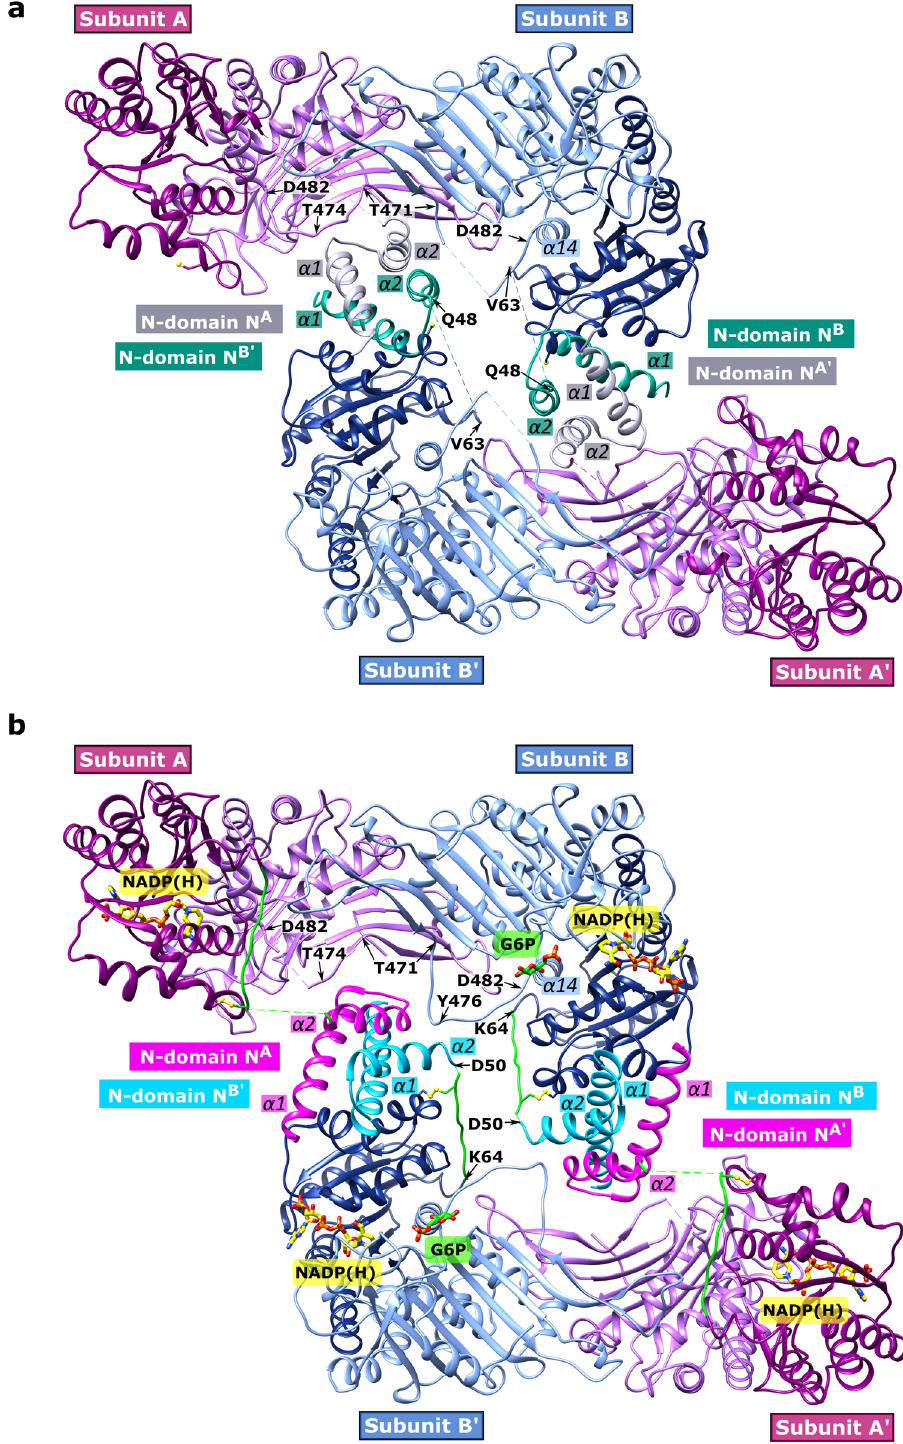
Fig. 3 Overview of the Ld G6PD wt tetramer. The tetramers of the apo a and the NADP(H)-complexed structures b are shown in the same orientation. The β - α domain (D249-K552) of subunits A/A ’ and B/B ’ is colored light purple and light blue, respectively. The “ Rossmann-like ” domain (D50-I248) of subunits A/A ’ and B/B ’ is colored dark magenta and navy blue, respectively. a apo structure. The helical N-terminal domain with α 1 (~D11-R31) and α 2 (~I36-K49) is colored gray in subunit A and A ’ (N-domains N A and N A ’ ) and colored dark cyan in subunit B and B ’ (N-domains N B and N B ’ with position P1). Dotted lines indicate regions with bad or missing electron density (subunit A/A ’ : G52-V63; subunit B/B ’ : K49-K62, T474-D477). b NADP(H)-complexed structure. N-domains N A and N A ’ are colored magenta and N-domains N B and N B ’ (position P1) are colored cyan. The connecting loop (D56-K64) is colored green, and dotted lines indicate regions with bad or missing electron density (subunit A/A ’ : D50-S55, Y476-R479; subunit B/B ’ : R51-E54). NADP(H) (yellow) and G6P (green) and residues are shown as sticks models. Important residues of the fl exible loop (T471-D482) and the connected helix α 14 (P481-L492) are directly or indirectly affected by the N-domains and marked with labels or arrows. The apo structure and the NADP(H)-complexed structure were used (PDBIDs: 7ZHT, 7ZHU), and G6P is taken from a superimposed structure with bound G6P (ribbon not shown, PDBID: